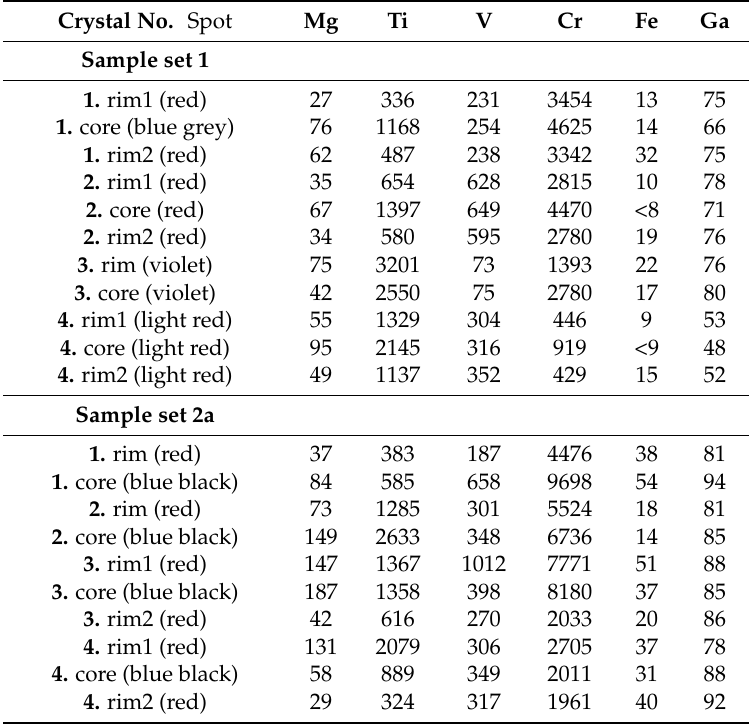
Table A2. LA-ICP-MS trace element values (ppm) 1 , Mong Hsu ruby sample sets. Crystal No.